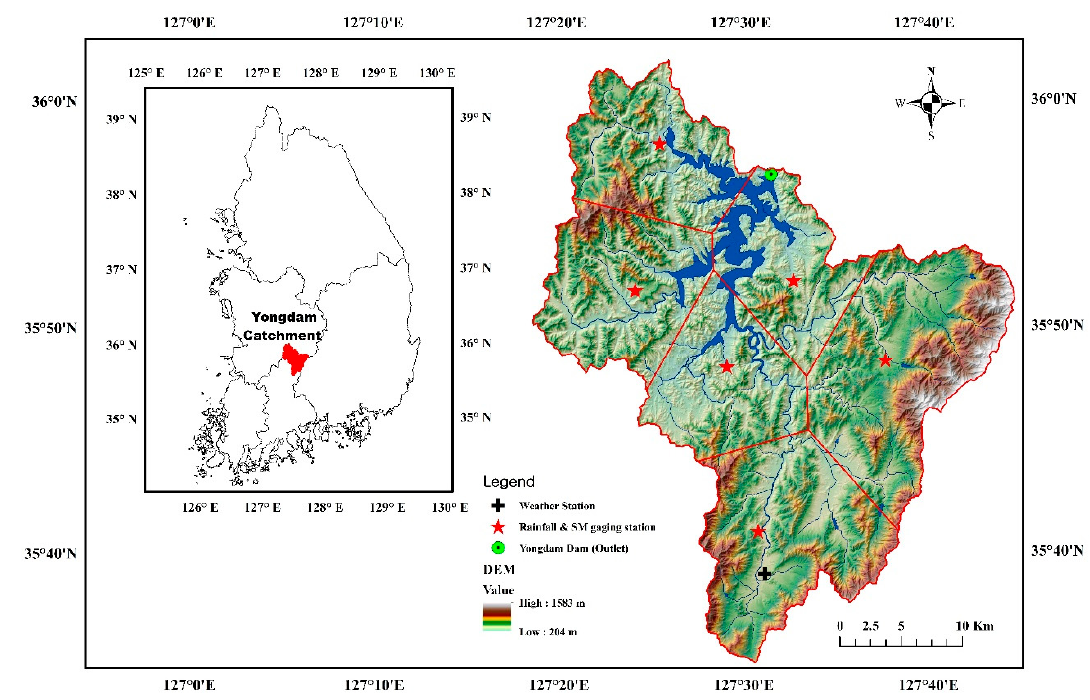
Figure 1. Map showing the study area along with the location of hydrologic and weather stations used in this research. The polygon enclosed within solid lines represents a Thiessen polygon for estimating the areal rainfall over the Yongdam Dam watershed. Note that the discharge gauging station is located at the Yongdam dam site.